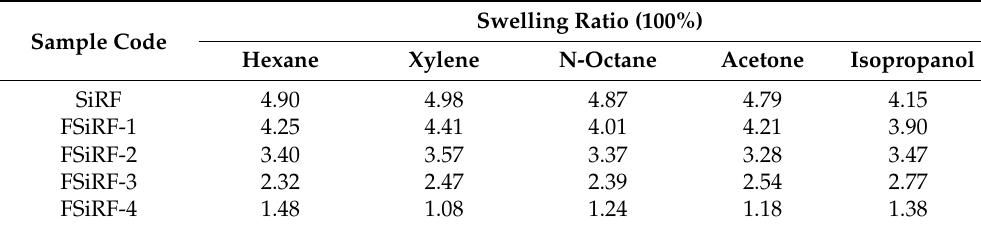
Table 2. Swelling ratios of FSiRF materials for different organic solvents. Sample